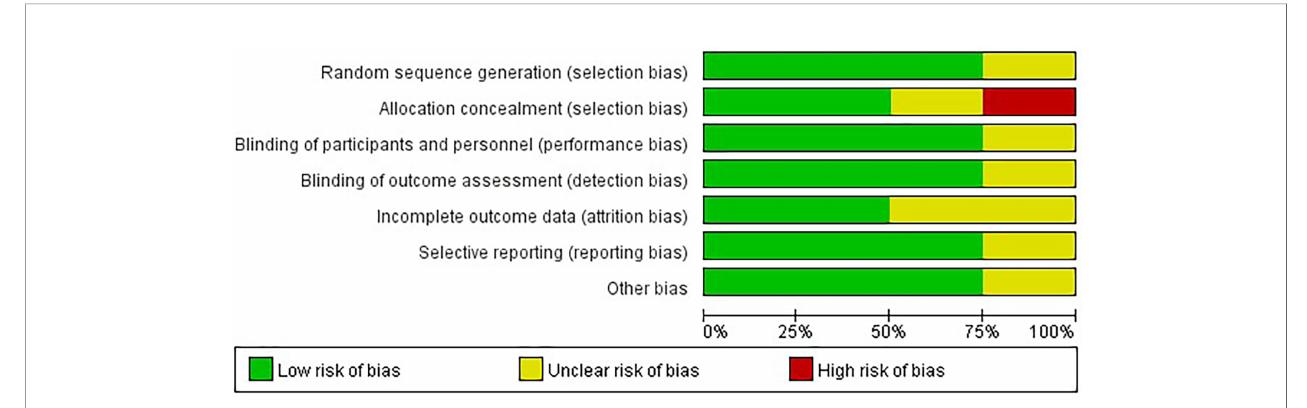
FIGURE 2 | Quality assessment of included